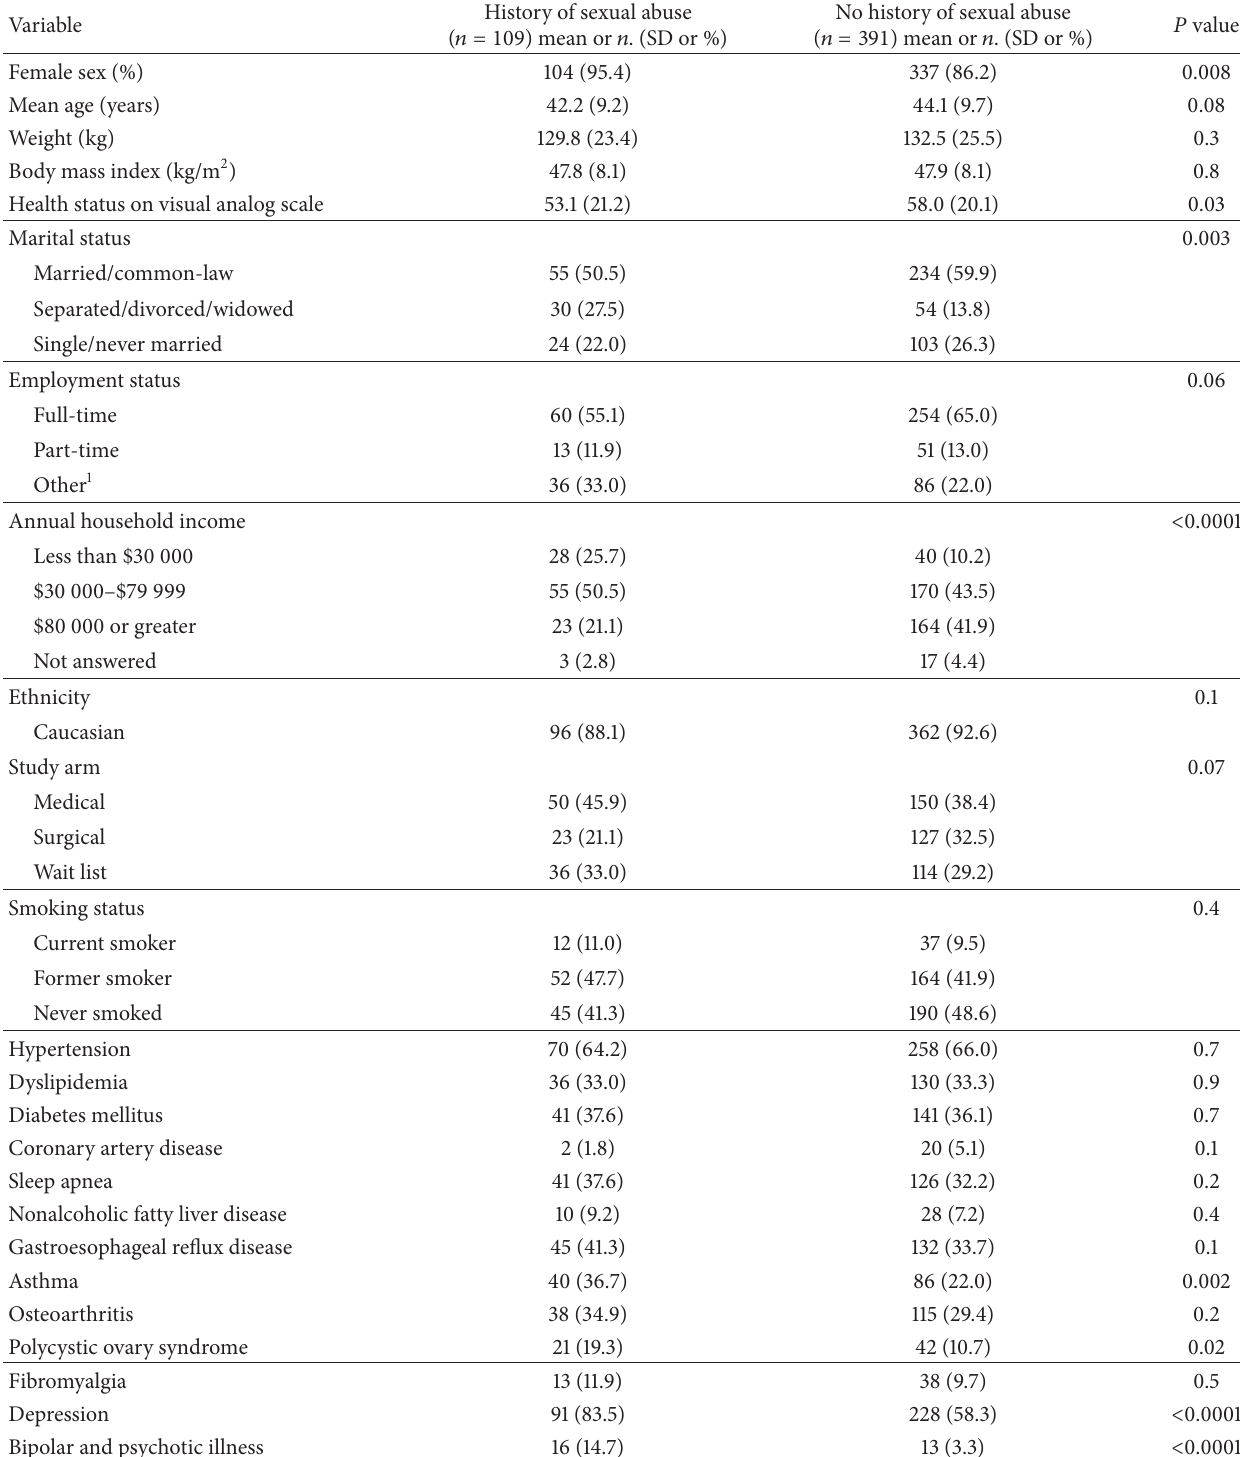
Table 1: Baseline